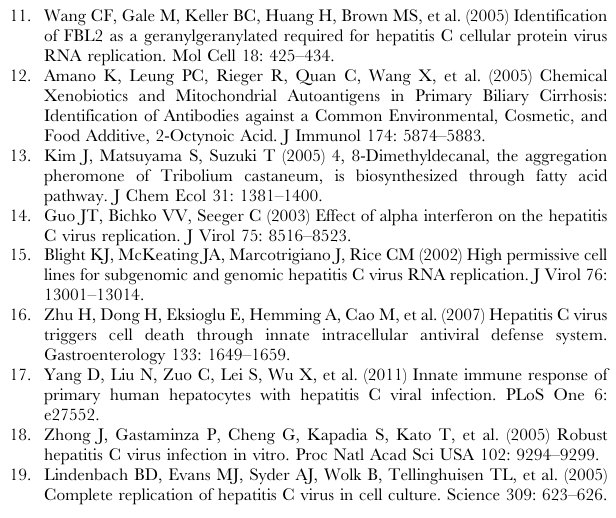
Figure S1 The effect of 2-OA on pT172 of AMPK in HCV replicon cell line and its parental cells at long time points. Huh7 and FCA1 cells were treated with 10 m M 2-OA for 48 and 72 hours. Protein was isolated from the cells. pT172 of AMPK was detected by western blot. b -actin was used as control. (TIF)